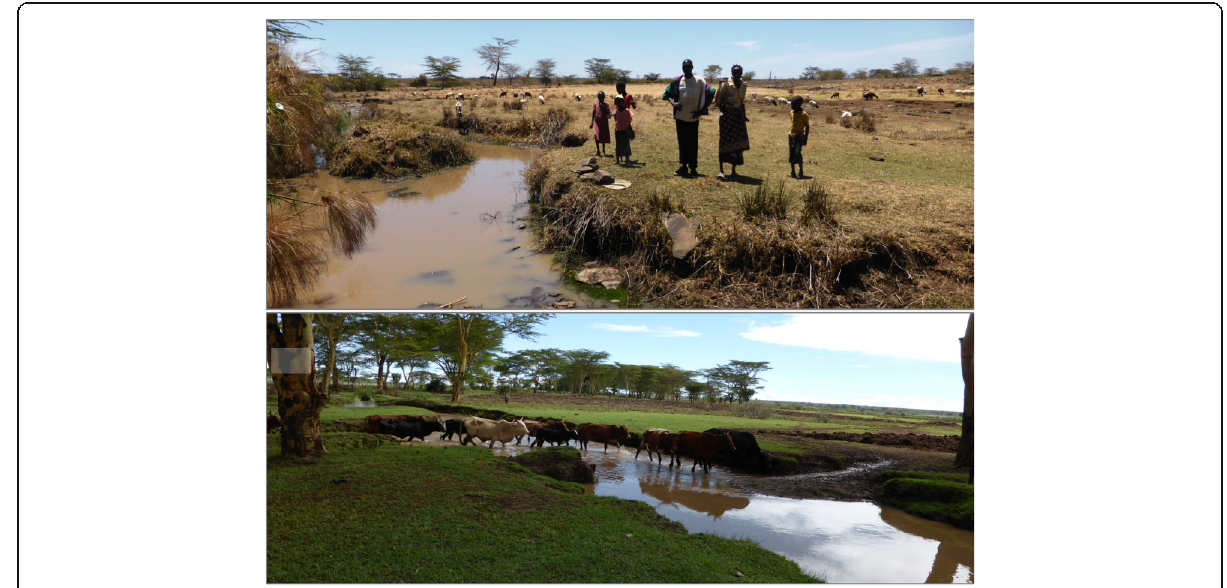
Fig. 2 The study area: the Ewaso Narok Swamp in semiarid Kenya